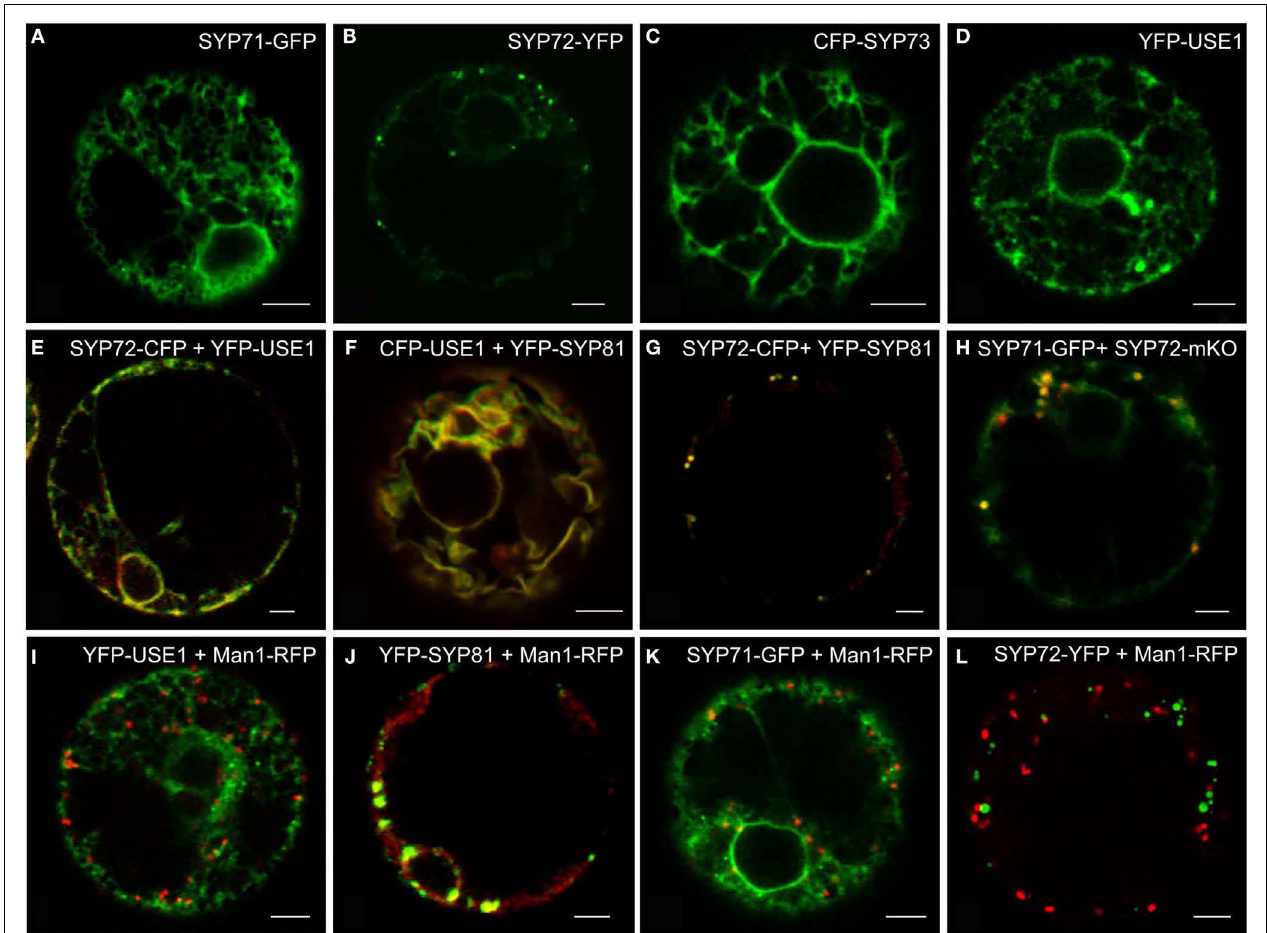
electroporated together with the cis -Golgi marker Man1-RFP (I–K) . CFP fluorescence is depicted in green (E–G) ,YFP in red (E–G) , GFP in green (H) , mKO in red (H) . Man1-RFP signals are always shown in red (I–L) . All images are of single optical sections. Magnification bars = 5 µ